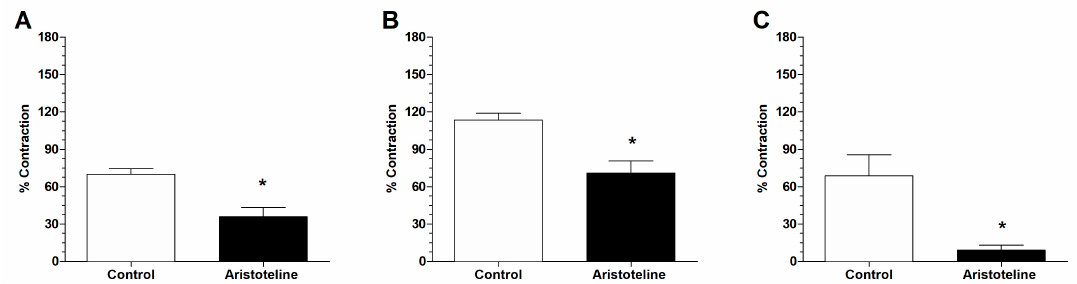
Figure 9. Evaluation of the ARI contraction mechanism associated with potassium channels. The aortic rings were pre-contracted with KCl (15 mM) ( A ), BaCl 2 (1 mM) as a blocker of inward rectifier potassium channels (Kir) ( B ), TEA (1 mM) as a non-selective blocker of KCa1.1 channels ( C ). The vascular tissue was pre-incubated in absence (control) or presence of ARI (10 µ M) for 20 min. Unpaired Student’s t-tests; n = 6. Statistically significant difference * p < 0.05 vs. Control.